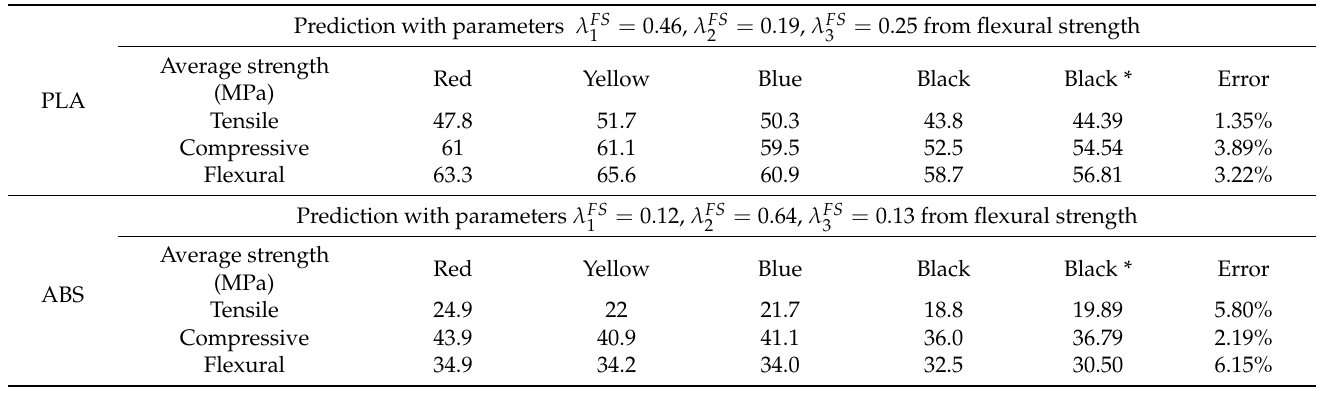
Table 7. Predicated values for mechanical strengths with four colors.